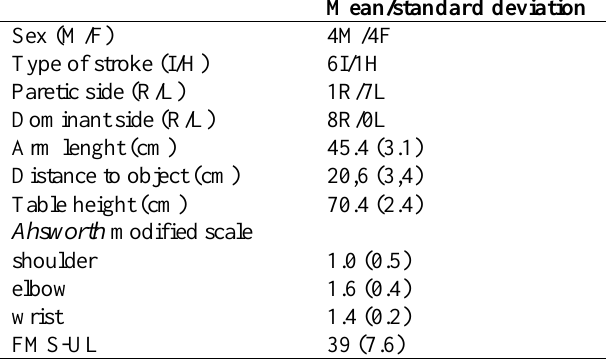
Figure 2. Example of a raw data obtained by the accelerometer for one trial in one participant showing acceleration traces of reach-to- grasp for A: non-paretic (NP) and B: paretic (P) upper limb